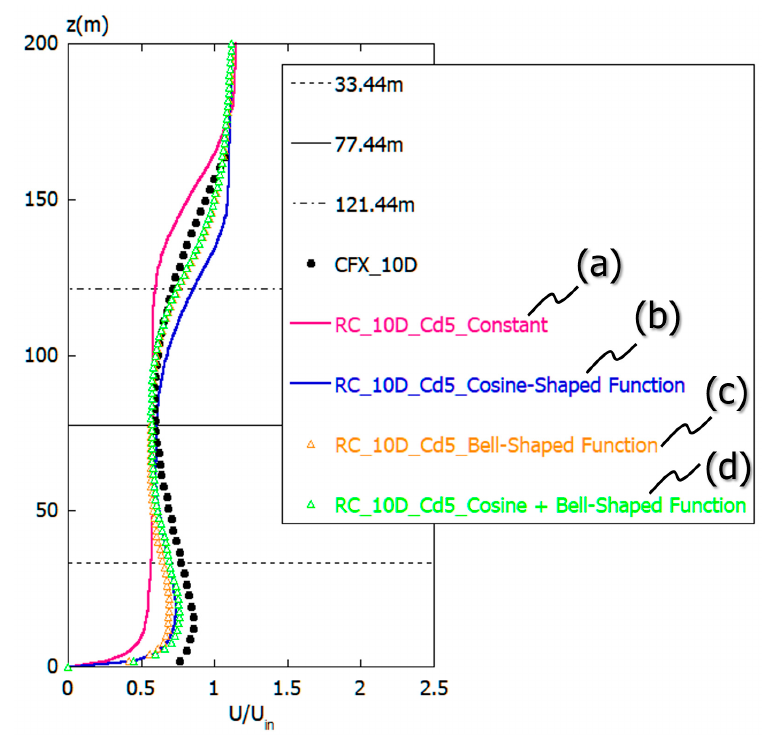
Figure A2. Comparison of vertical distribution of time-averaged U-velocities at x = 10D.